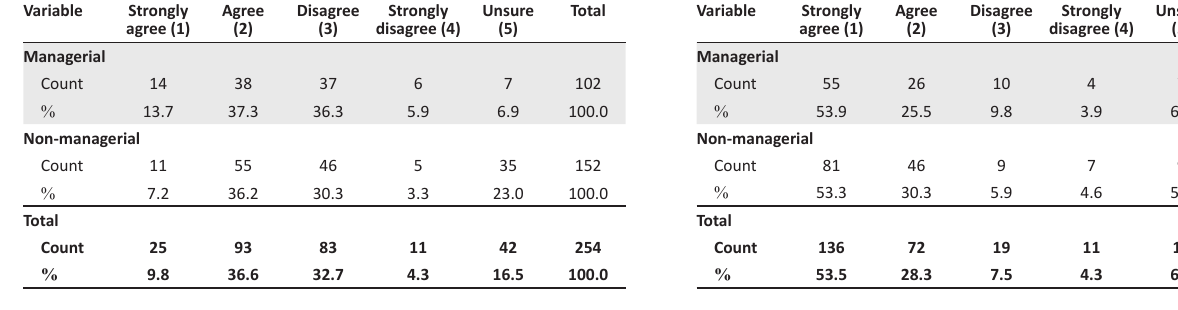
TABLE 4: Participants’ responses on provision of personalised products and services. Variable